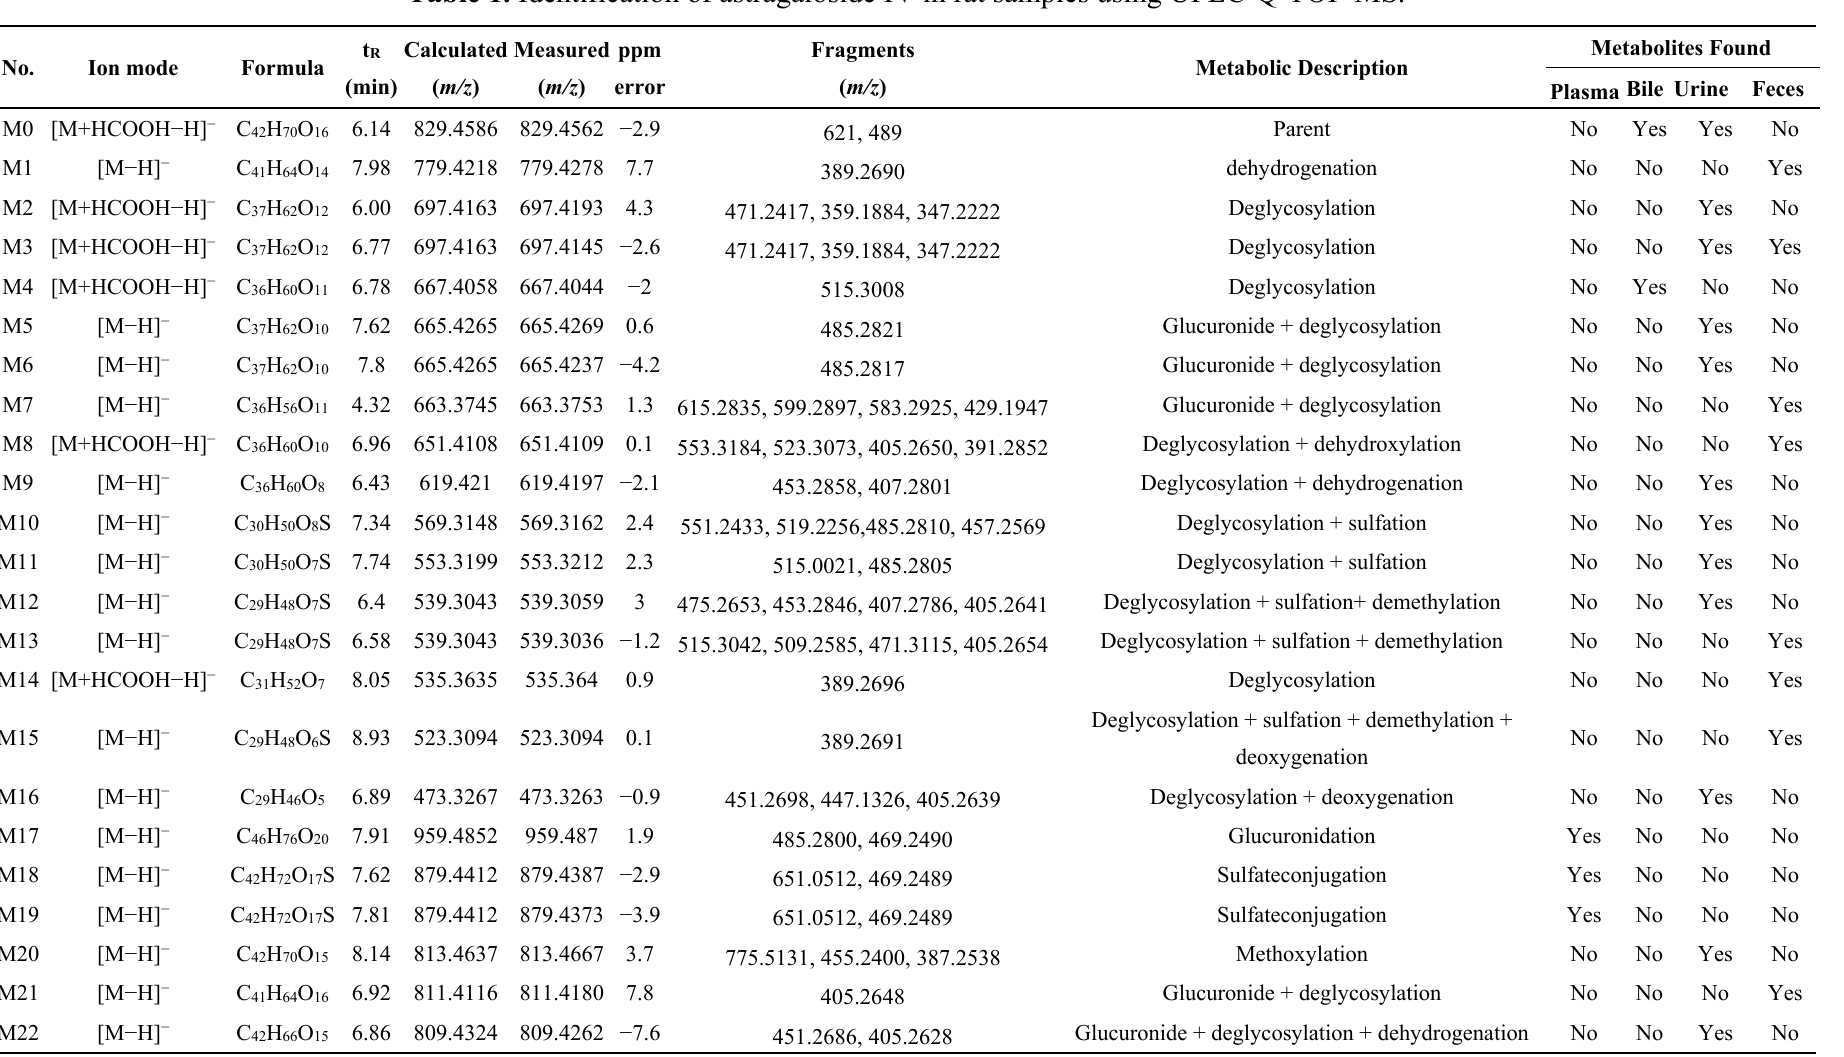
Table 1. Identification of astragaloside IV in rat samples using